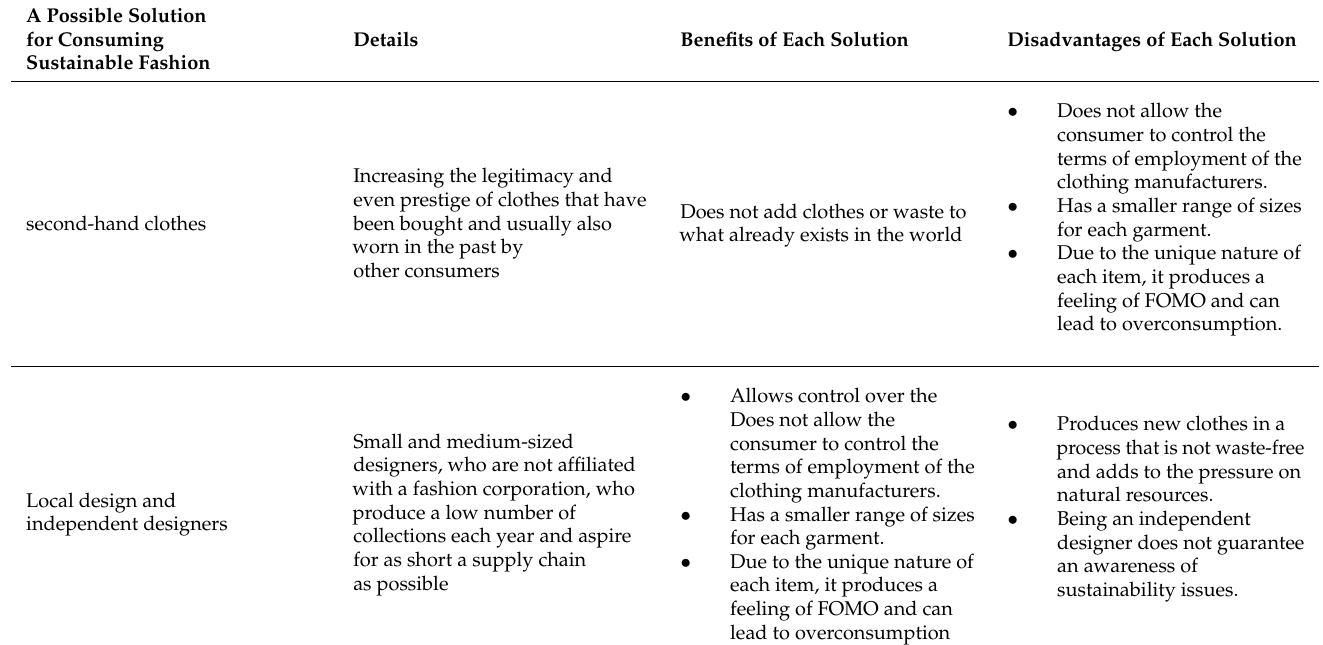
table of the main alternatives (See Table 1): Table 1. Different approaches to sustainable fashion, advantages and